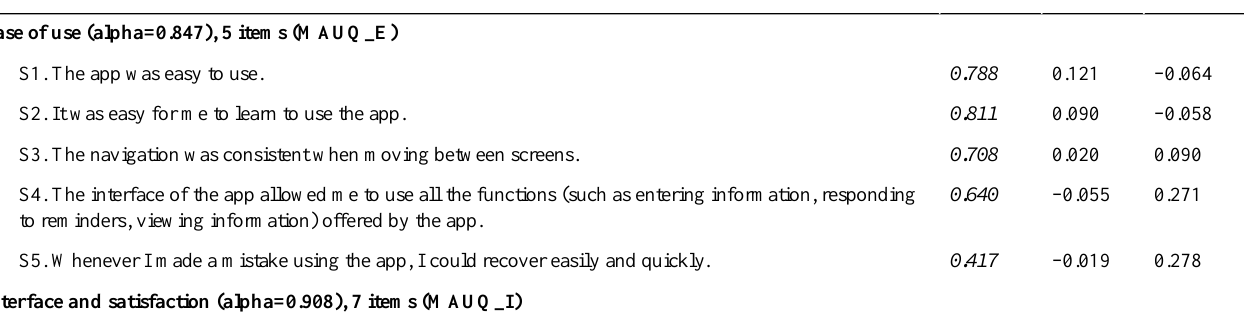
Table 4. Exploratory factor analysis results for the 18 items on the mHealth App Usability Questionnaire designed for standalone mHealth apps (overall Cronbach alpha=0.914). Values >0.32 for each factor are italicized. Ease of use (alpha=0.847), 5 items (MAUQ_E)